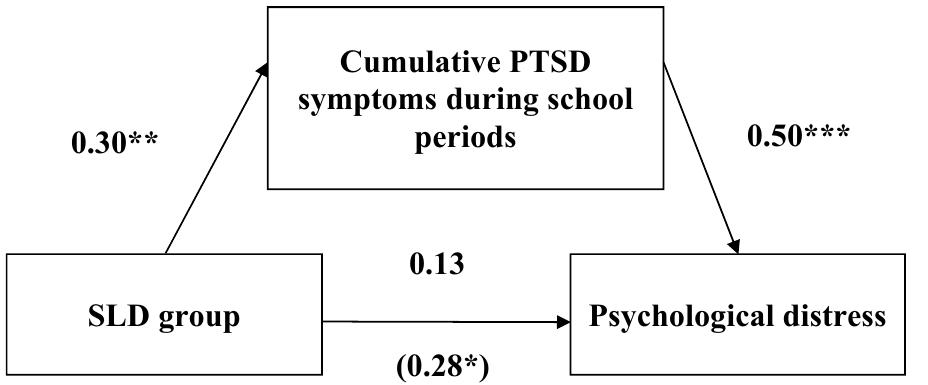
Figure 1. Unstandardized regression coefficients for Study 2 variables. Unstandardized regression coefficients for the pathways among SLD (0 = No; 1 = Yes), cumulative PTSD during school periods (0 = 0; 1 = Only in one school period either elementary or high-school; 2 = Both), and psychological distress. ** p < .05, ** p < .01, *** p <